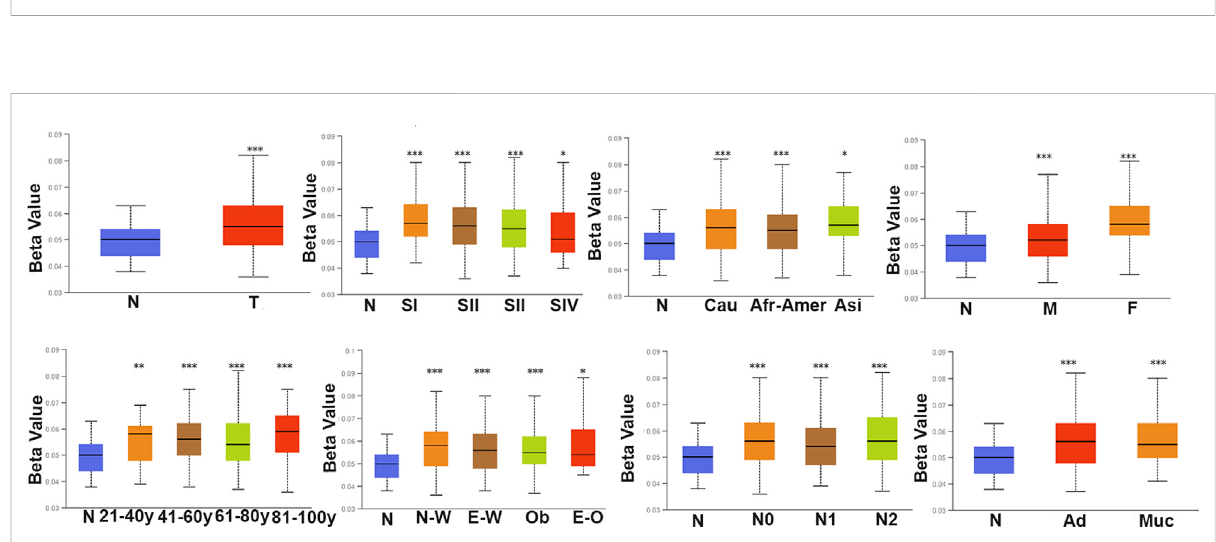
FIGURE 3 The methylation level of ARID1B across different clinicopathological parameters in COD patients. There is a signi fi cant difference between the de fi ned subgroups containing gender, age, race, histological subtype, tumor grade, and nodal metastasis status of